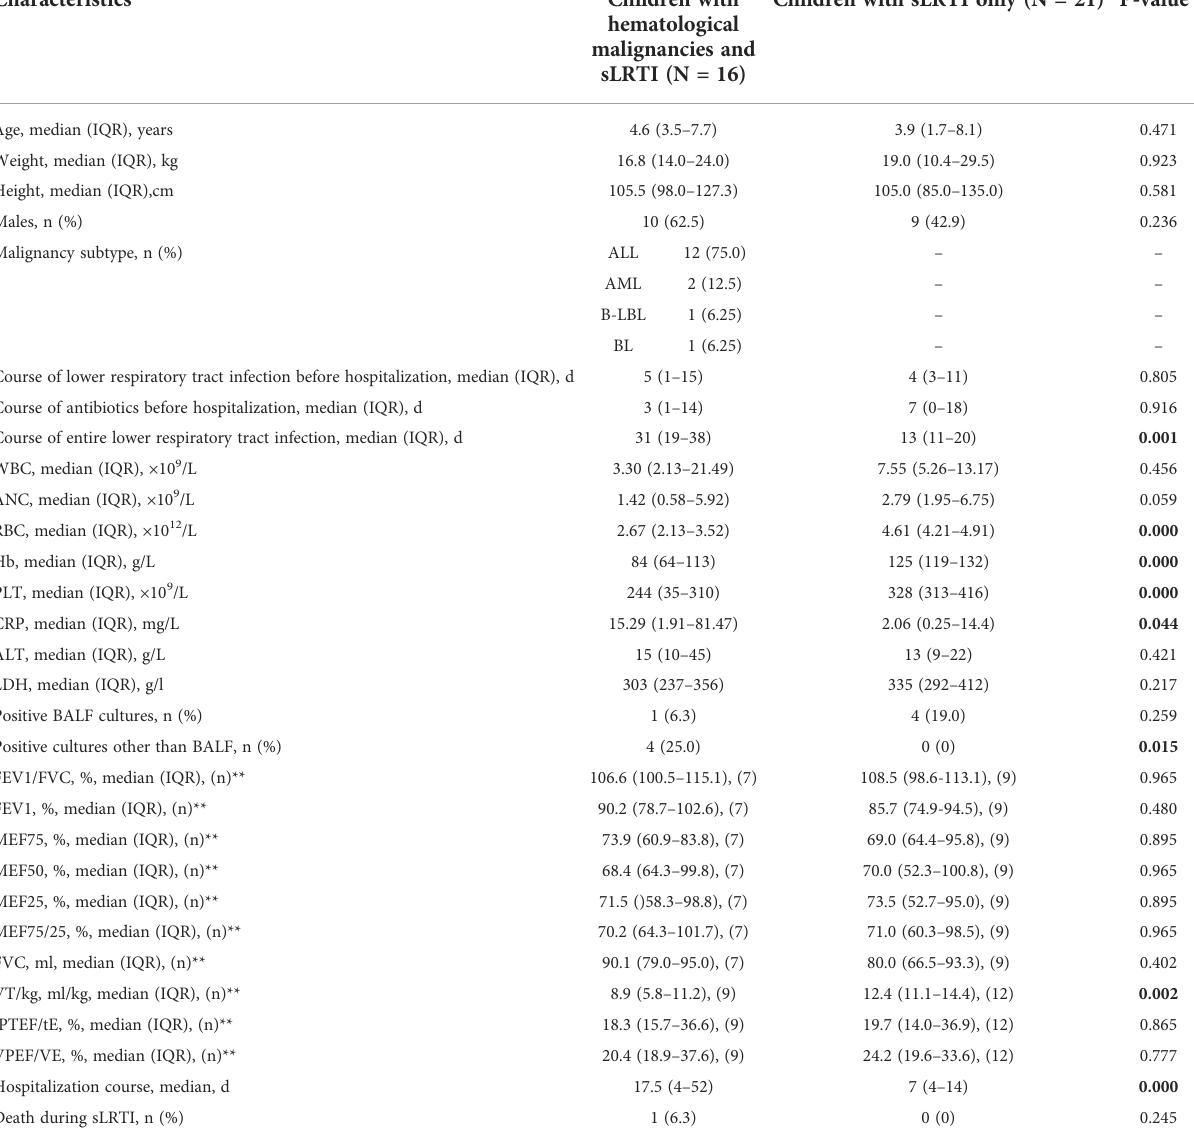
TABLE 1 Comparison of the demographics, clinical course, features, and outcome of lower respiratory tract infection (LRTI) children with/ without hematological malignancies. Characteristics Children with